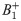

B1+ inhomogeneity displayed as histograms of the flip-angle accuracy factor inside the brain of six healthy human volunteers.Voxels outside the head or not containing brain tissue were masked out. The dashed lines indicate the mean (thick line) plus/minus the standard deviations (thin lines) of ηα across subjects.